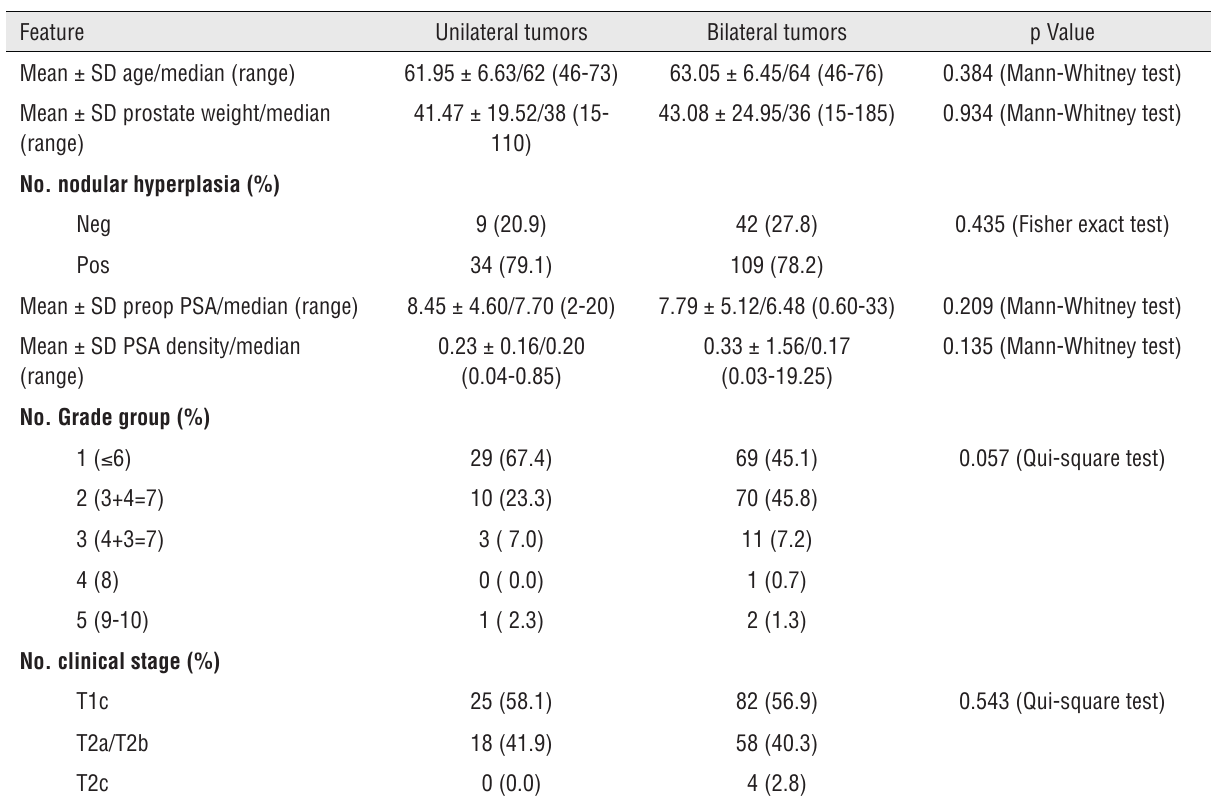
Table 1 - Clinicopathological features of 43/196 (21.9%) unilateral tumors vs 153/196 (78.1%) bilateral tumors by total tumor extent.